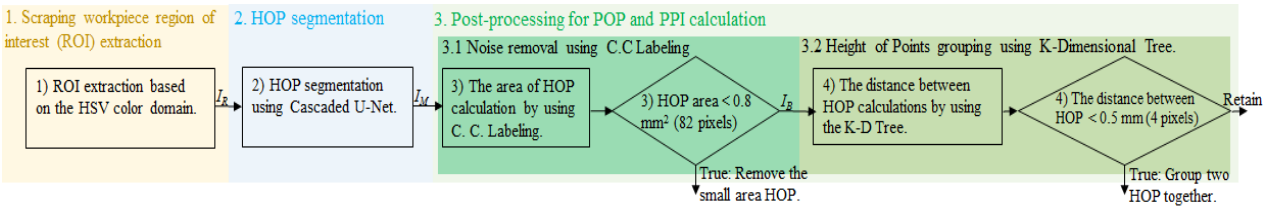
Figure 4. The flowchart of POP and PPI calculation on cloud computing.